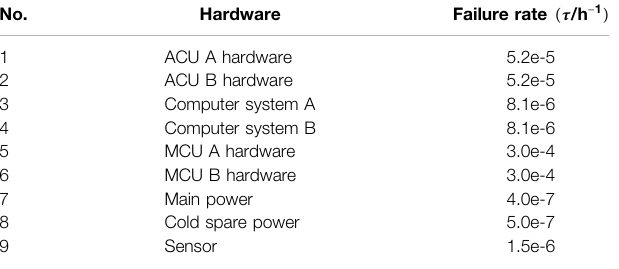
TABLE 2 | Failure rates of hardware for the DPCSNR.